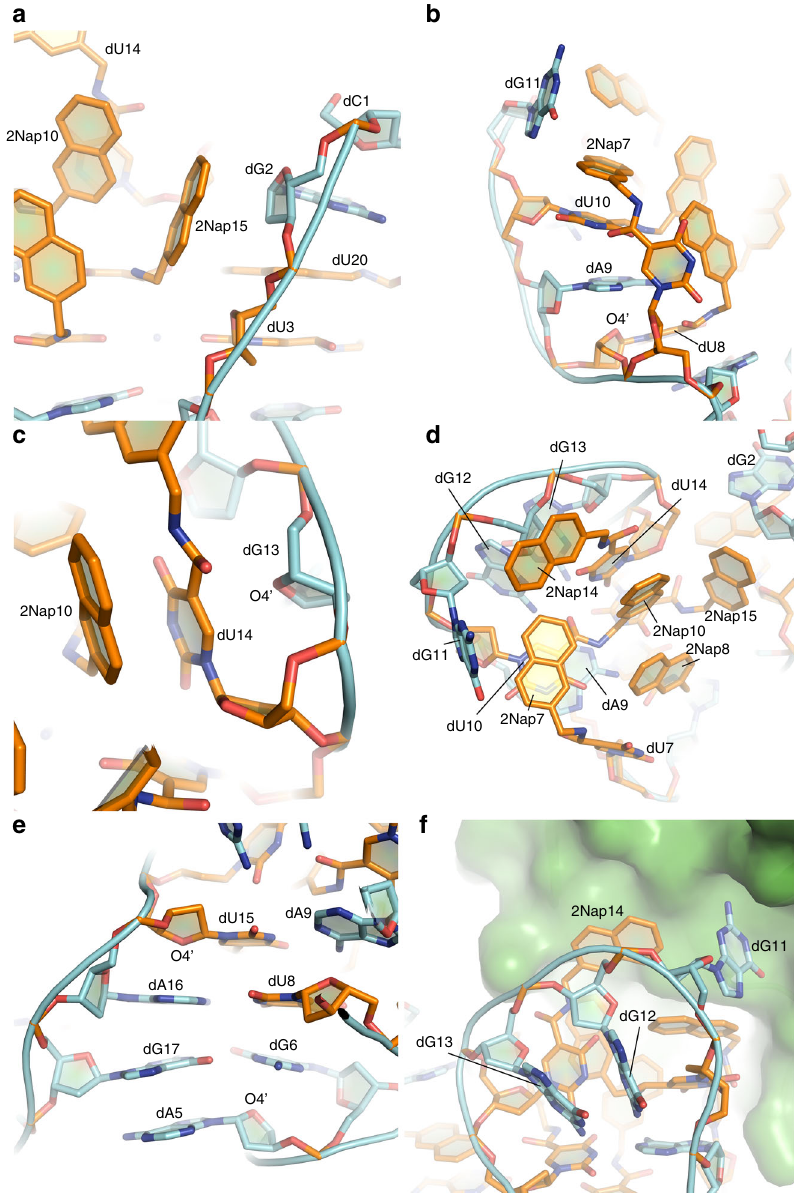
Fig. 3 Key elements of the SL1067 structure. a The snap formed by 2Nap15 and the sugar ring of dG2 combines the stem and loop regions of SL1067. b Multilayer stacking of 2Nap7, the base of dU10 and the base of dA9 is capped with O4 ʹ of dU8. c O4 ʹ (dG13) caps the Nap-base stack between dU10 and dU14. d The hydrophobic cluster on SL1067. The dU7 and 2Nap8 residues form a classical edge-to-face π interaction. Two other pairs of edge-to-face π interactions are formed between 2Nap10 and 2Nap15, and 2Nap14 and dG11. 2Nap8 makes face-to-face stacking with 2Nap10. e Four-layer base stacking is capped with the O4 ʹ of the dU15 sugar ring on the top and the O4 ʹ of dA5 sugar ring on the bottom. The stacking is further strengthened by the base pairings of dA9-dU15, dA16-dU8 and dG17-dG6. f In the loop region, the dG12 and dG13 base rings form face-to-face stacking and dG11 protrudes toward